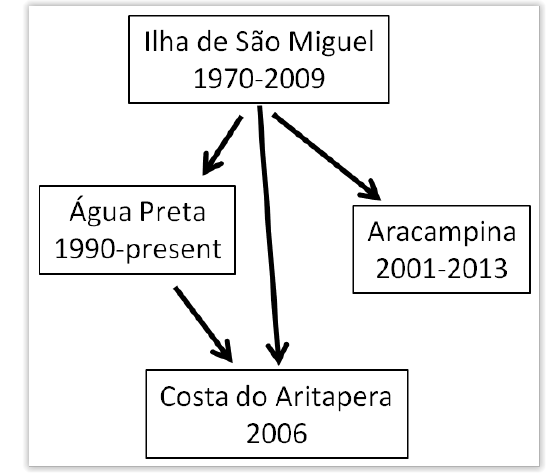
Fig. 3 . Scheme showing how knowledge, values, and motivations to protect a tabuleiro have traveled across